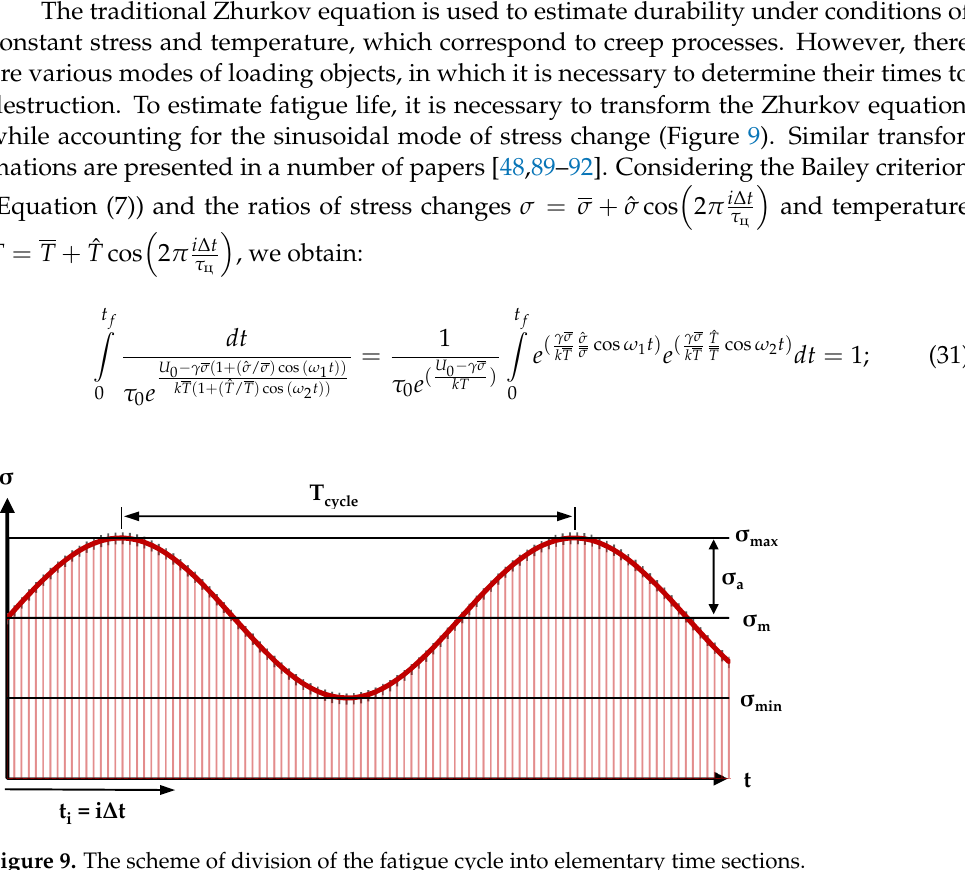
Figure 9. The scheme of division of the fatigue cycle into elementary time sections.